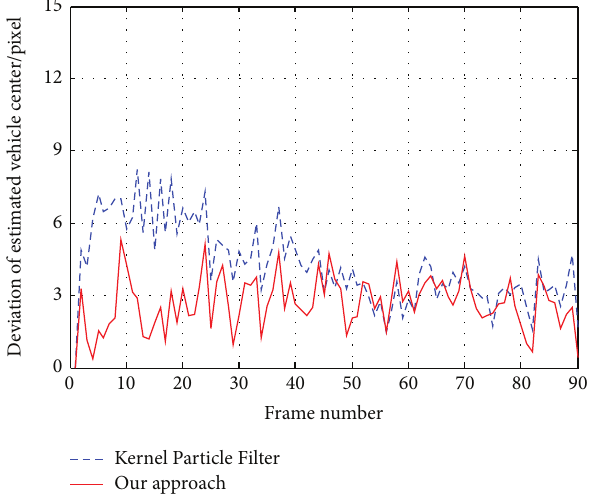
Figure 9: Deviation with different numbers of particles by our